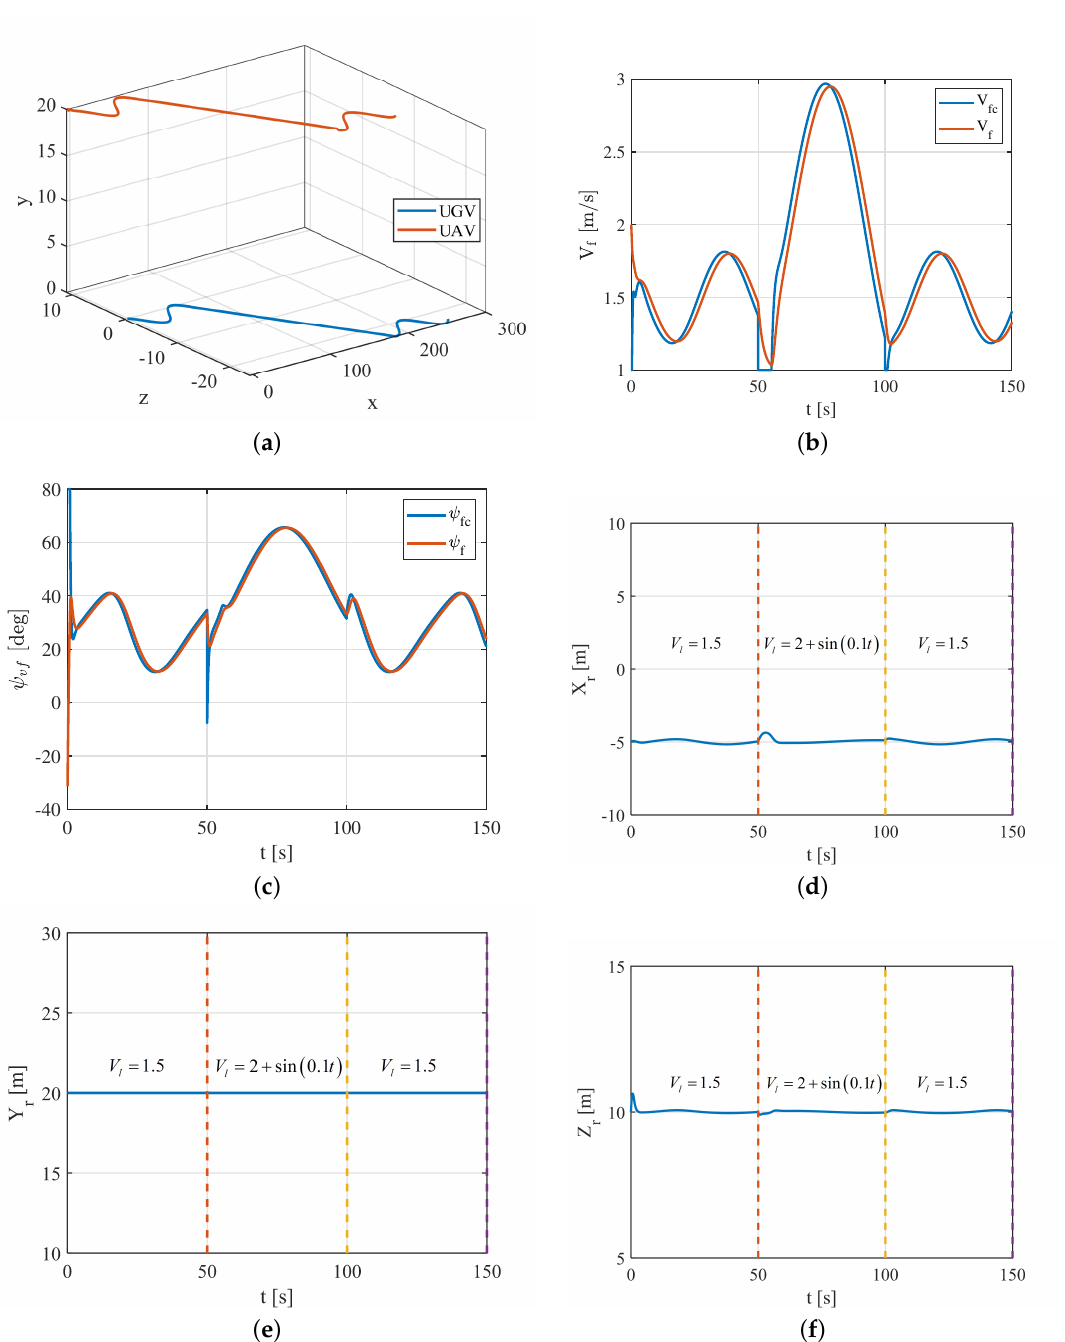
Figure 2. Simulation results of case 2. ( a ) Three-dimensional motion trajectory of UGV and UAV; ( b ) velocity of UAV; ( c ) deflection angle of UAV; ( d ) motion trajectory in X r -axis direction; ( e ) motion trajectory in Y r -axis direction; ( f ) motion trajectory in Z r -axis